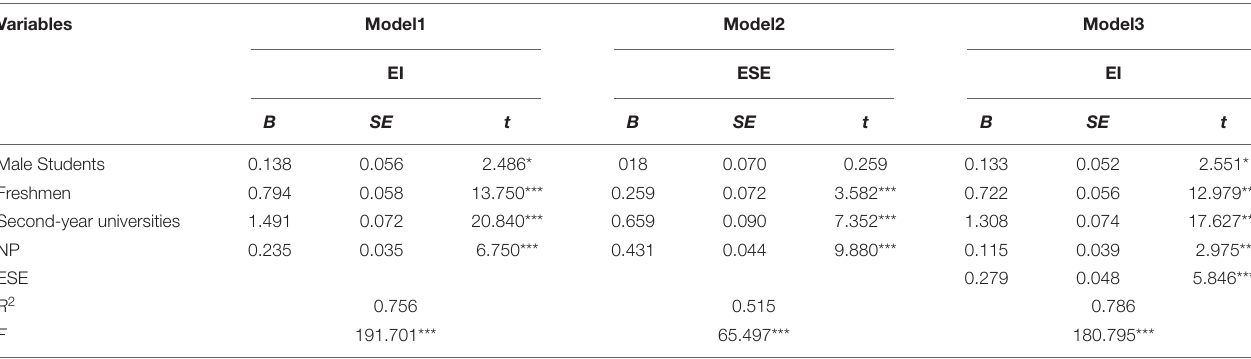
TABLE 3 | Testing the mediation model of entrepreneurial